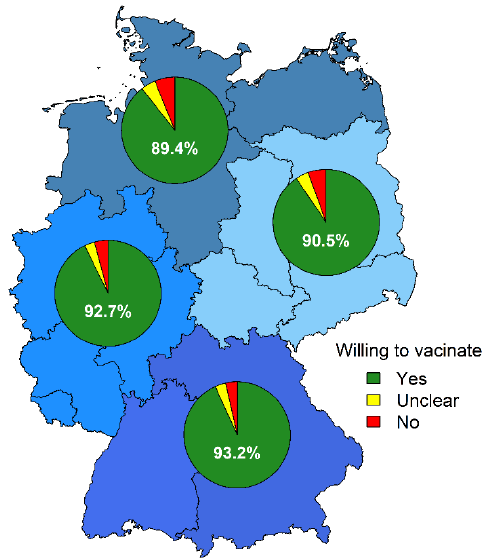
Figure 2. COVID-19 vaccination acceptance in German regions. Regions defined according to the region definitions in the COVIMO study [42]. Numbers of invitations, responses and inhabitants per region and federal country [43] can be found in Table S2.